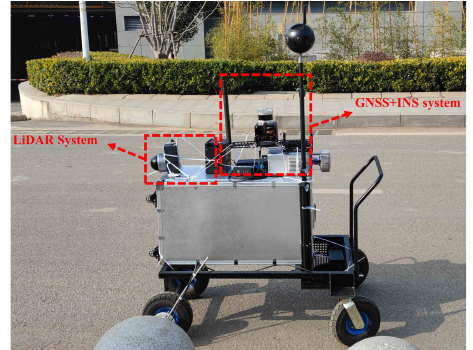
Figure 6. The equipment for outdoor data collection